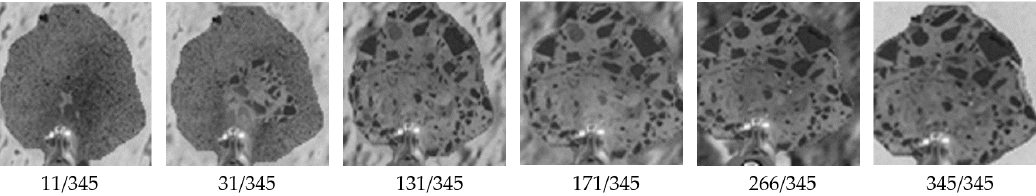
Figure 17. Spalling pattern for six points during fire exposure for the specimen with a size of 300 × 300 mm.